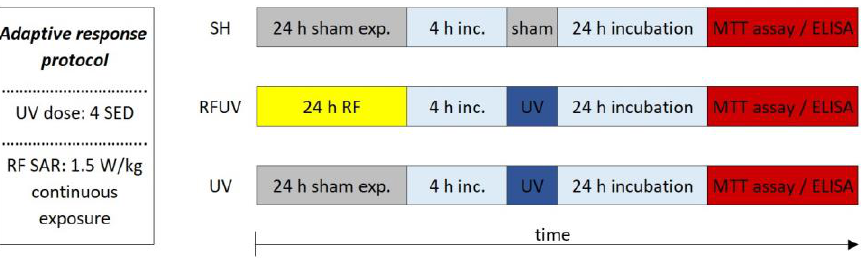
Figure 6. Timeline of the adaptive response protocol.